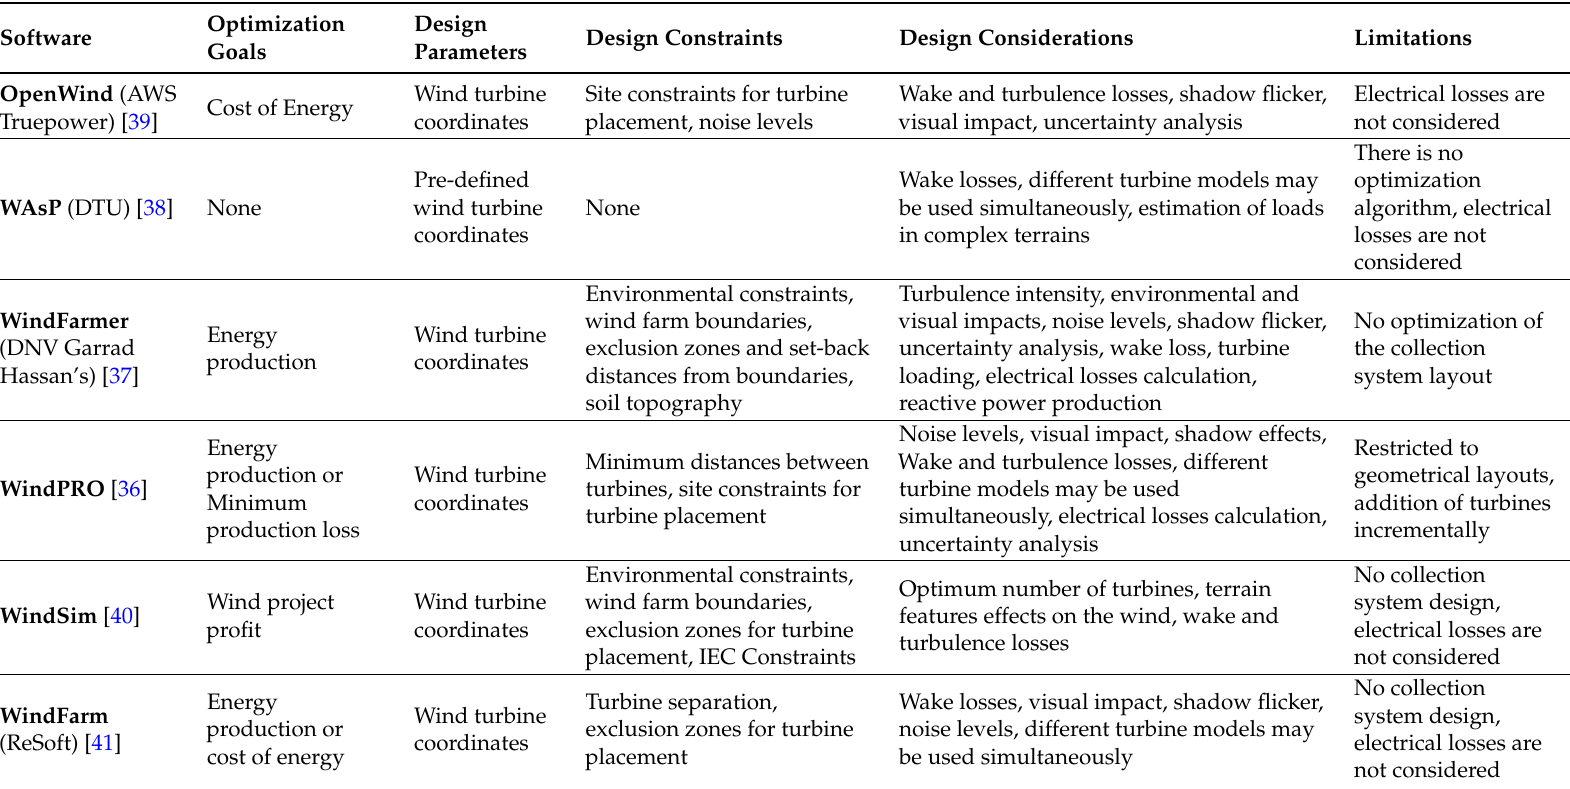
Table 2. Wind Farm Design Software Commercially